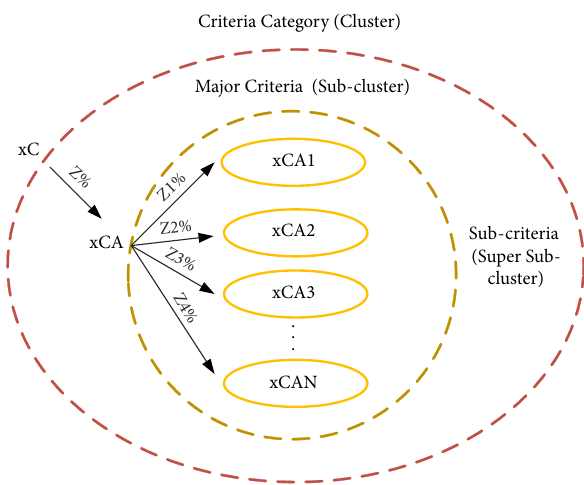
Figure 7. Schematic diagram showing weights distribution